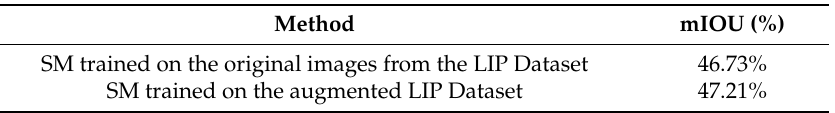
Table 5. The influence of domain randomization on the SM.